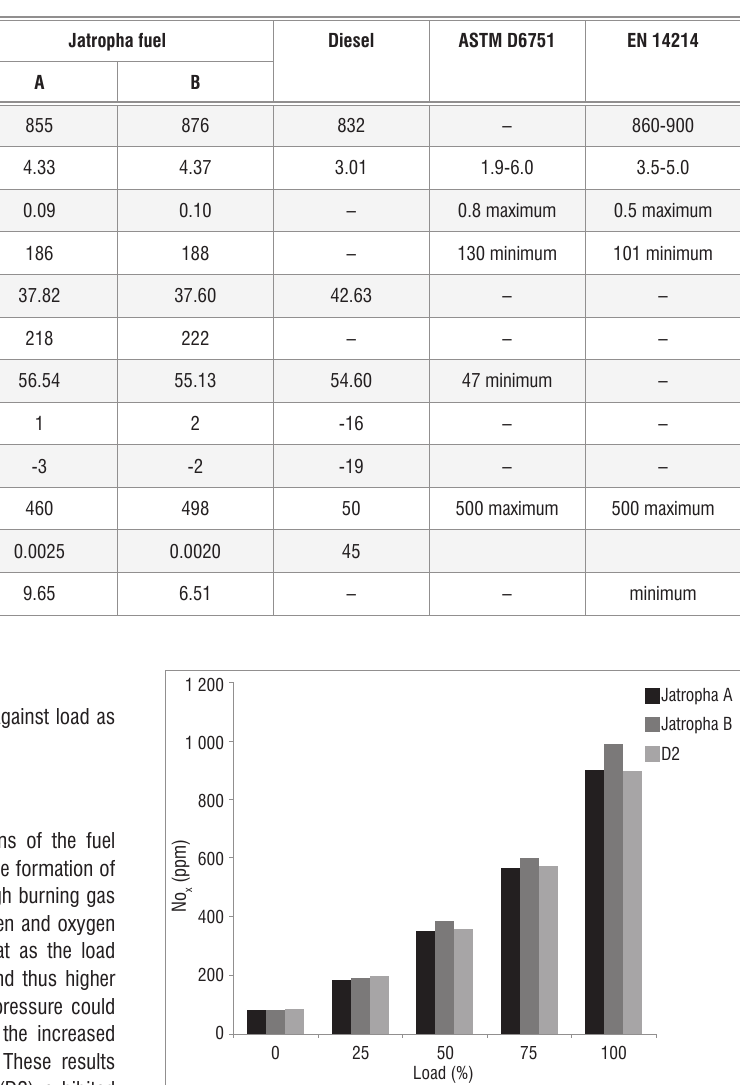
Polyunsaturated fatty acid methyl esters Fuel properties of biodiesels Jatropha A and B, diesel and biodiesel